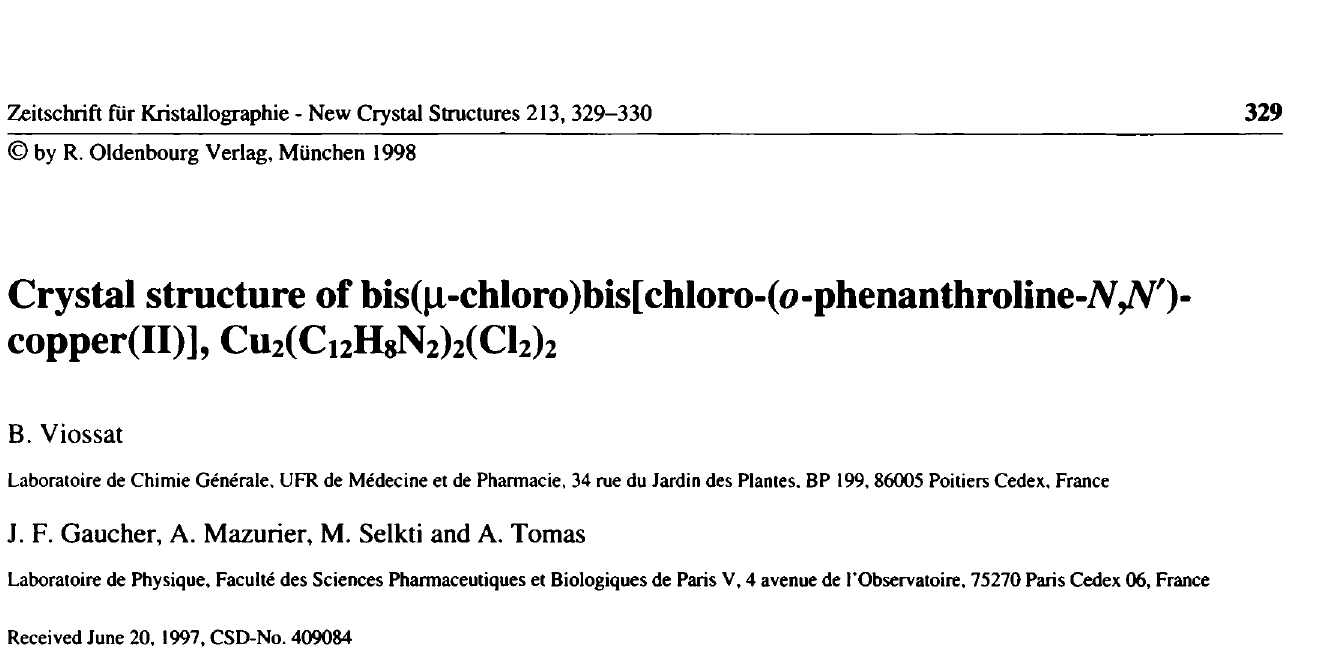
Table 2. Final atomic coordinates and displacement parameters (in À^)